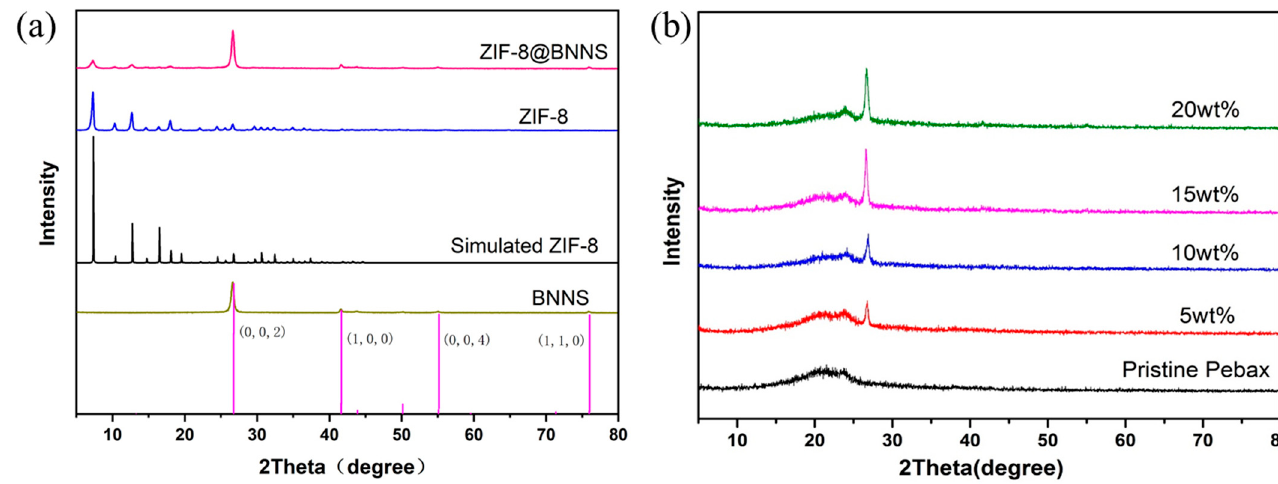
Figure 2. XRD pa tt erns of ( a ) ZIF-8, BNNS, and ZIF-8@BNNS and ( b ) Pristine Pebax and MMMs Figure 2. XRD patterns of ( a ) ZIF-8, BNNS, and ZIF-8@BNNS and ( b ) Pristine Pebax and MMMs with di ff erent loadings. with different